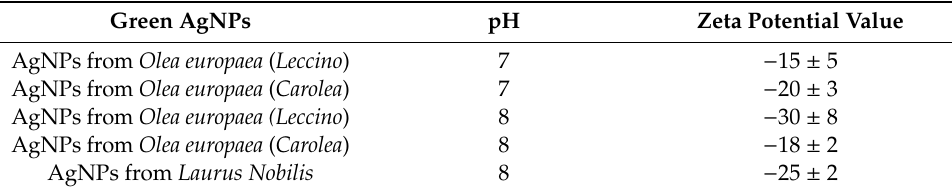
Table 1. ζ -potential values of green silver NPs (AgNPs) achieved at di ff erent pH. Green AgNPs